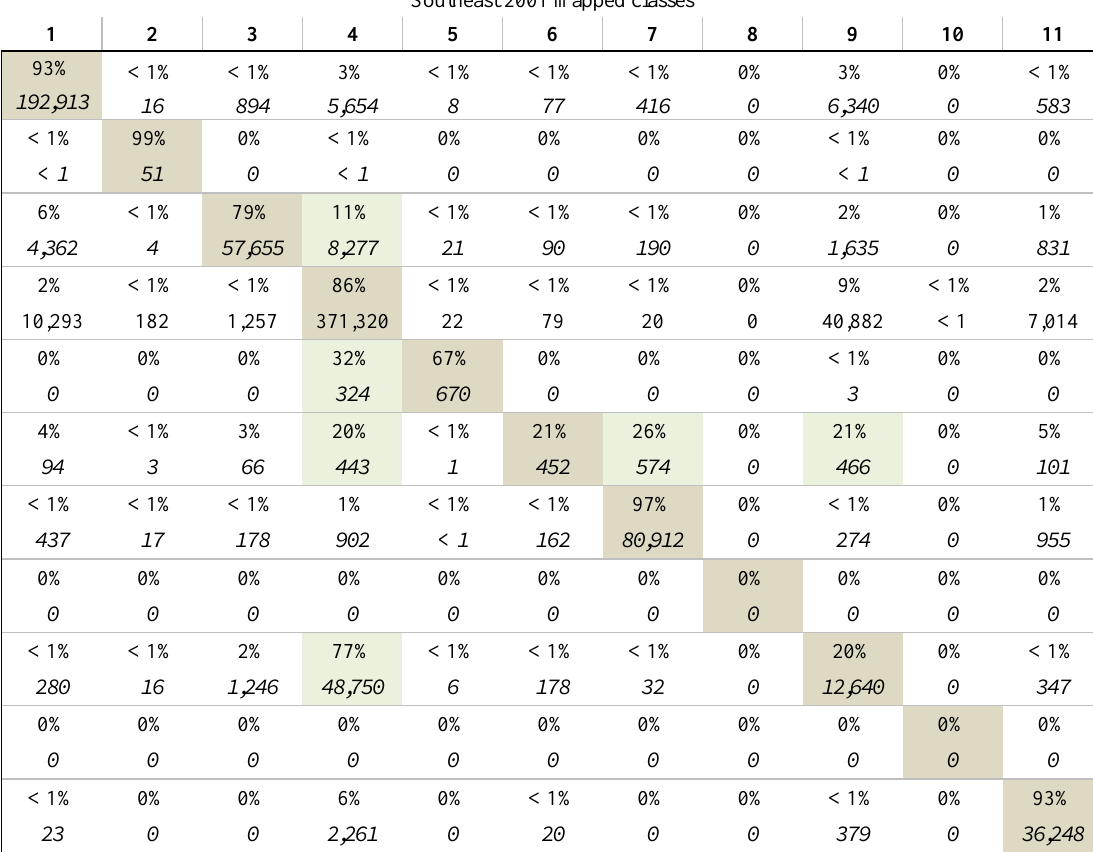
Table 2c. Percent and area (km 2 ) for each general land cover class in the 2001 and 2011 maps for the Northeast geoarea. Codes correspond to the land cover classes in Table 1. Diagonals are highlighted for ease of reading, and off diagonals are highlighted where greater than 10% of the 2001 General Land Cover Class was different in